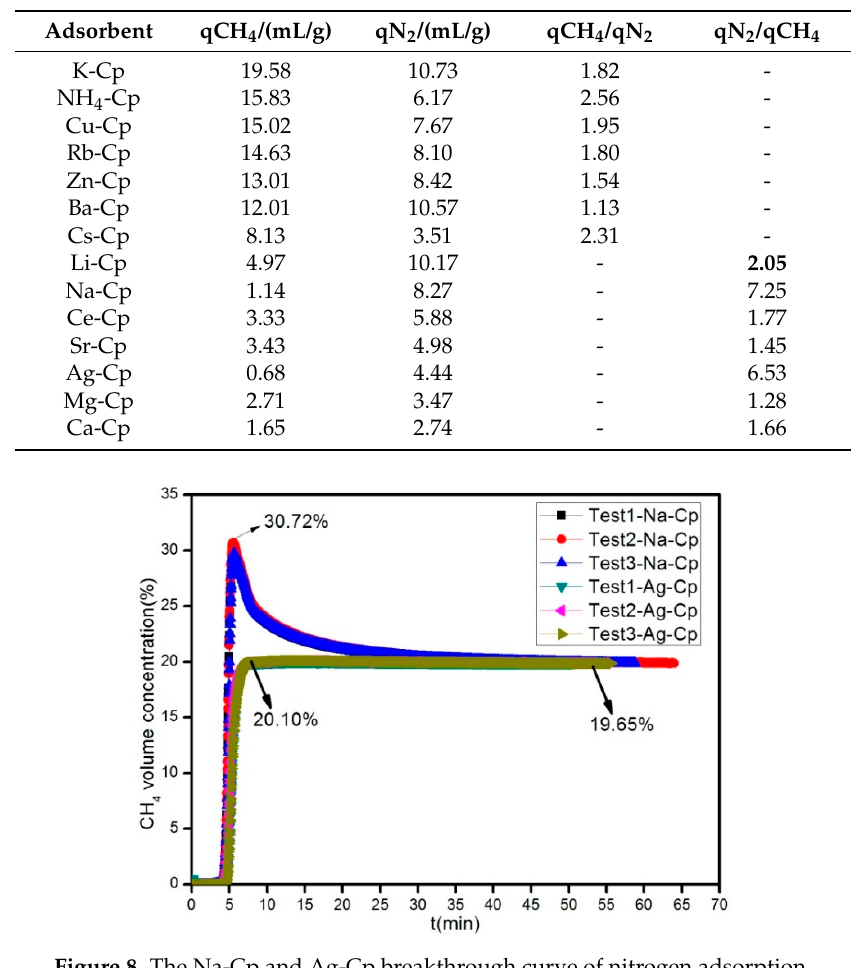
Figure 8. The Na-Cp and Ag-Cp breakthrough curve of nitrogen adsorption. Table 2. The adsorption capacity of clinoptilolite for CH 4 and N 2 (at a pressure of approximately 1.01 × 10 5 Pa at 298 K).